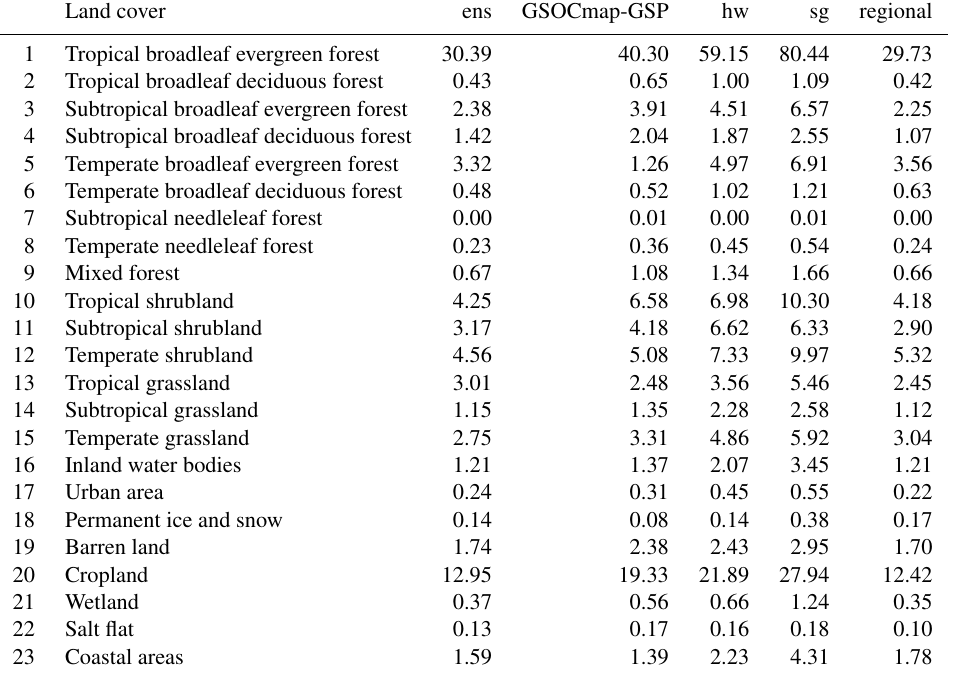
Table 4. SOC stocks at the contextual resolution of 5 × 5km across land cover classes of Latin America for the 18 analyzed countries. The terms used are defined as follows: ens is country-specific, regional is Latin America ensemble, sg is the SoilGrids system, GSOCmap-GSP is country-specific 1km, and hw is the Harmonized World Soil Database. These are the land cover classes described in Blanco et al. (2013). This land cover product was generated using 500m grids and has 84% of